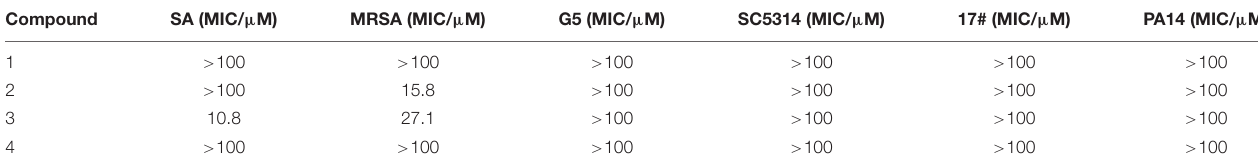
TABLE 4 | Antimicrobial activity of compounds 1 – 4